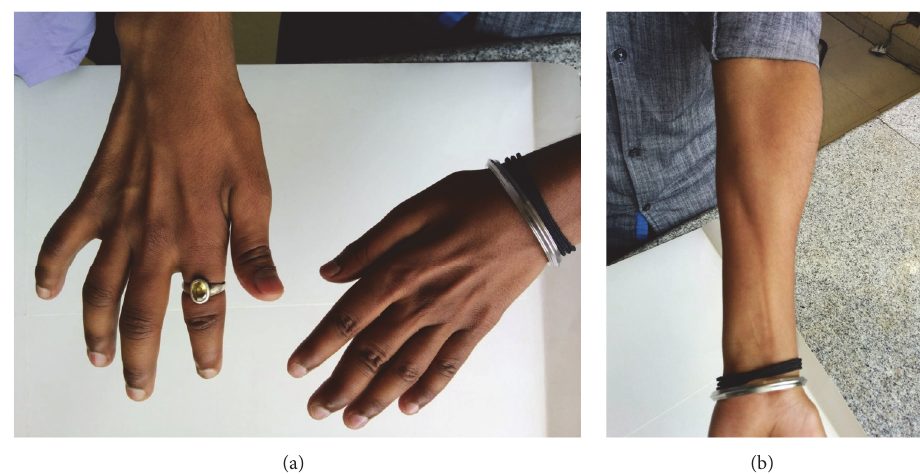
Figure 1: (a) Wasting of bilateral hands. (b) Wasting of the left forearm with sparing of brachioradialis muscle.